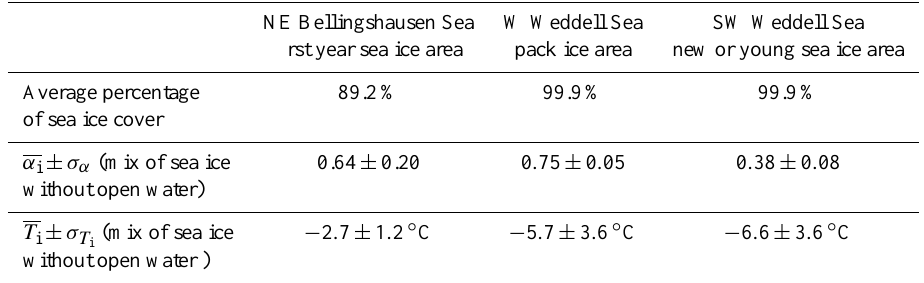
Table 2. Averaged sea ice albedo of data listed in Table 1 for the north-eastern Bellingshausen Sea, western Weddell Sea and south-western Weddell Sea with average percentage of sea ice